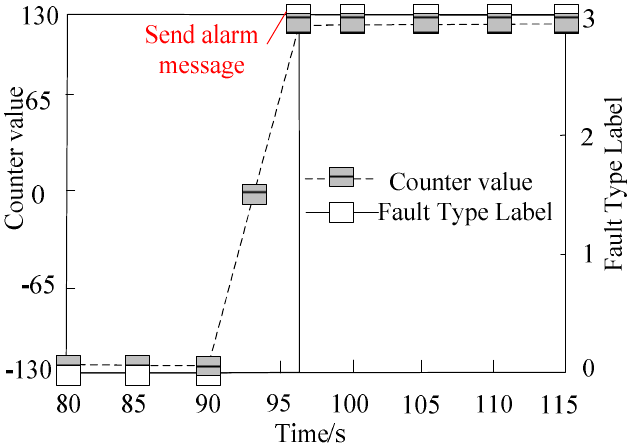
Figure 12. Real-time alarm results for hydraulic pump/motor faults by the proposed method.